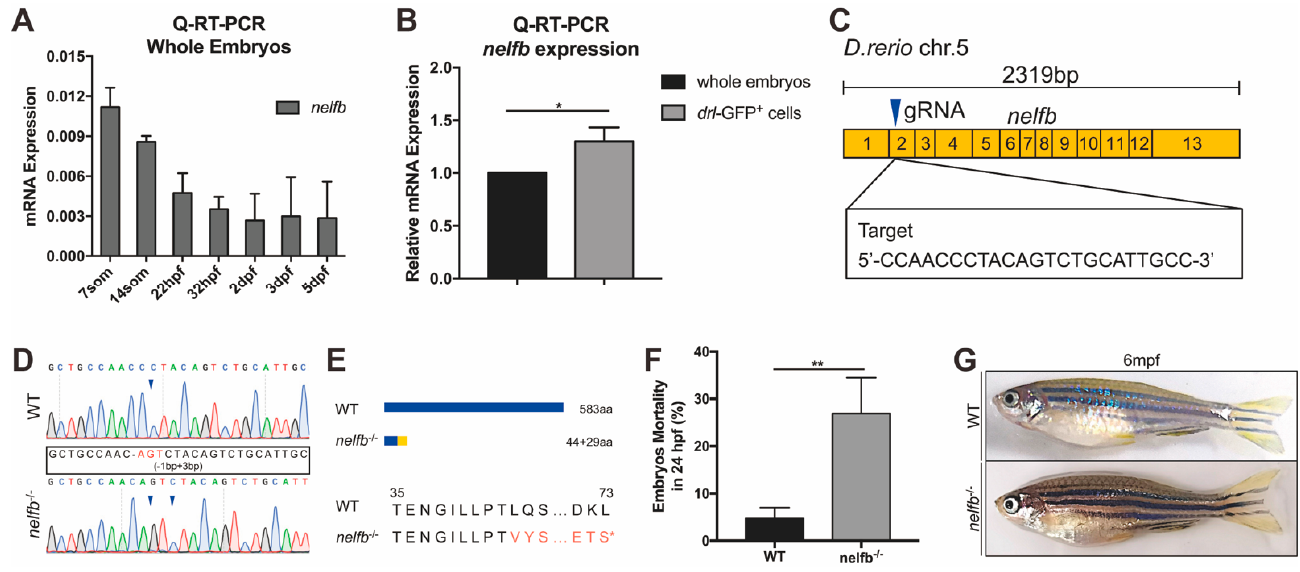
Figure 1. Expression of nelfb during development and generation of zebrafish nelfb mutants. ( A ) Q-RT-PCR analysis of whole embryos to show the expression of nelfb at different stages. The relative expression of nelfb is normalized to the expression of β -actin . ( B ) Q-RT-PCR analysis of the relative expression of nelfb in sorted drl -GFP + cells compared with the whole embryo lysates at 24 hpf. ( C ) The schematic diagram of nelfb cDNA and the targeted region of guide RNA. The target DNA sequence is shown in the rectangle. ( D ) Sanger sequencing analysis of PCR fragments containing the gRNA targeted region from WT and nelfb deficient homozygotes. The deleted nucleotides are replaced by -, and the inserted nucleotides are in red, as shown in the rectangle. ( E ) Schematic representation and amino acid sequences of the wild type Nelfb and the predicted truncated protein. ( F ) The mortality rate of embryos at 24 hpf ( n = 100–300 embryos per group). ( G ) Images of adult zebrafish at 6 mpf. All results are presented as the mean ± SD from three independent experiments ( t test, * for p < 0.05, ** for p < 0.01). WT, wildtype; hpf, hours post-fertilization; mpf, months post-